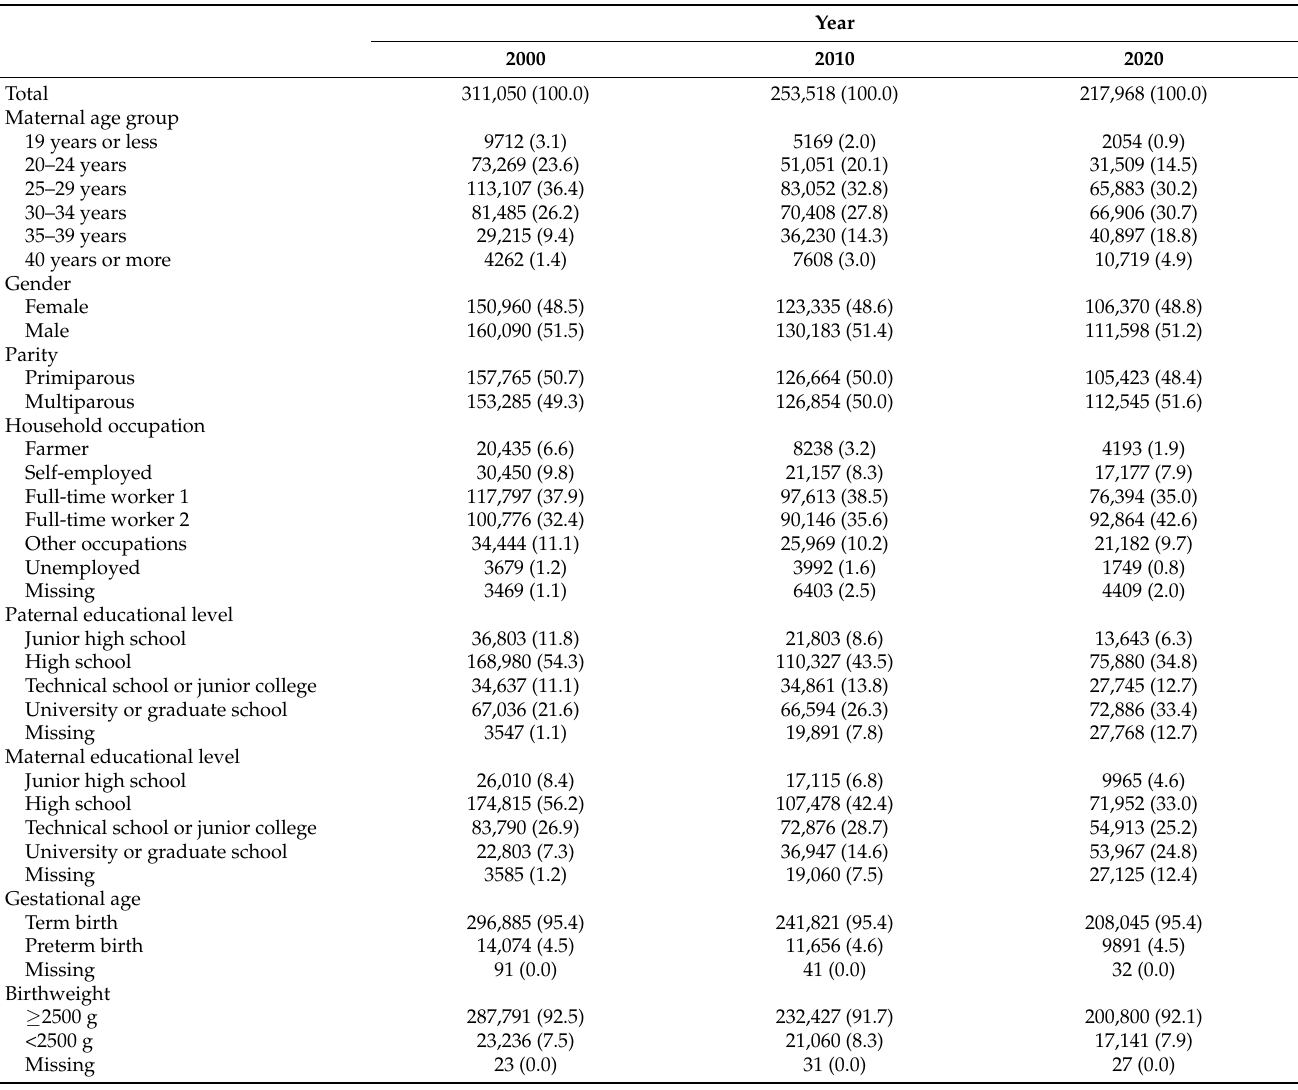
Table 1. Number of births (%) for each characteristic by year.